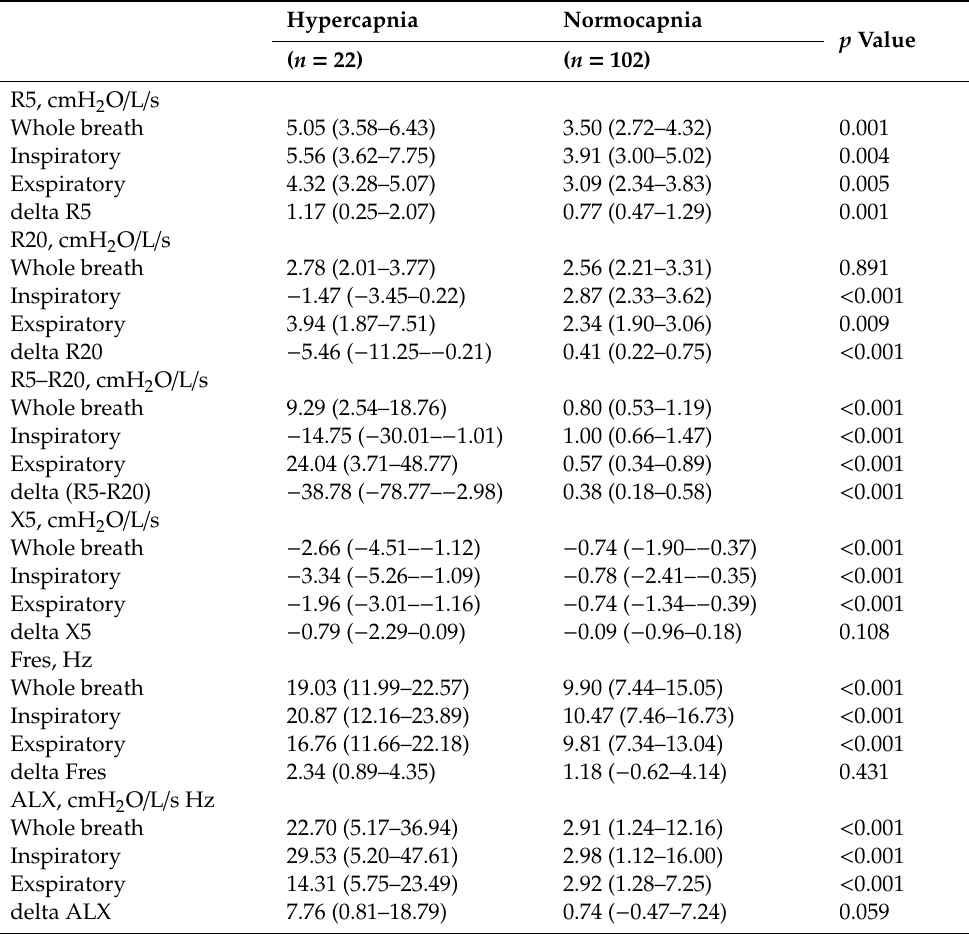
Table 3. FOT values of enrolled subjects with COPD.